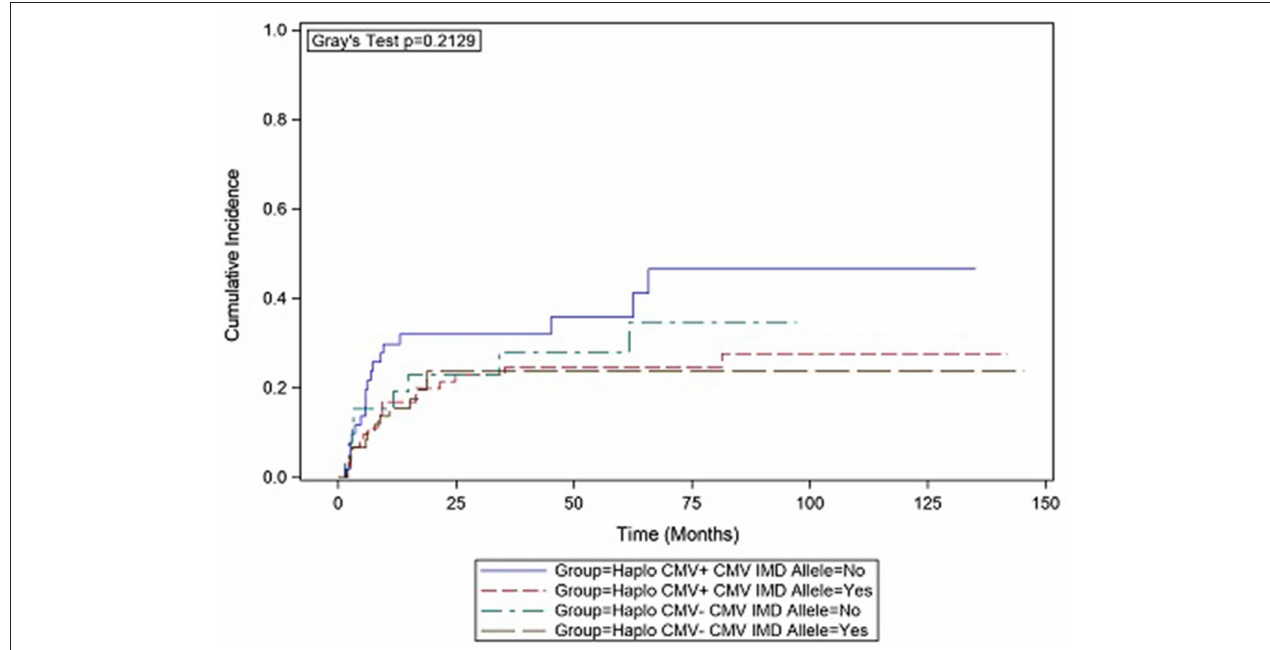
FIGURE 2 | CMV + patients without a CMV immunodominant allele had the highest cumulative incidence of relapse. although the results did not reach statistical significance.